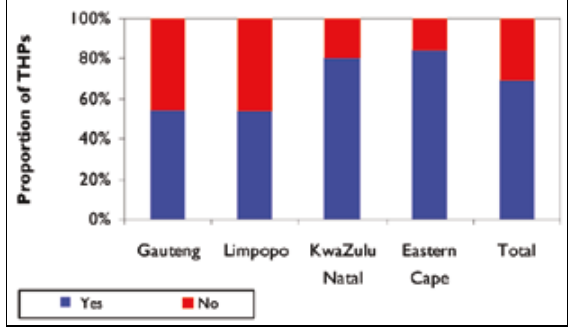
Fig. 2. THPs referring patients to clinics for HIV testing.